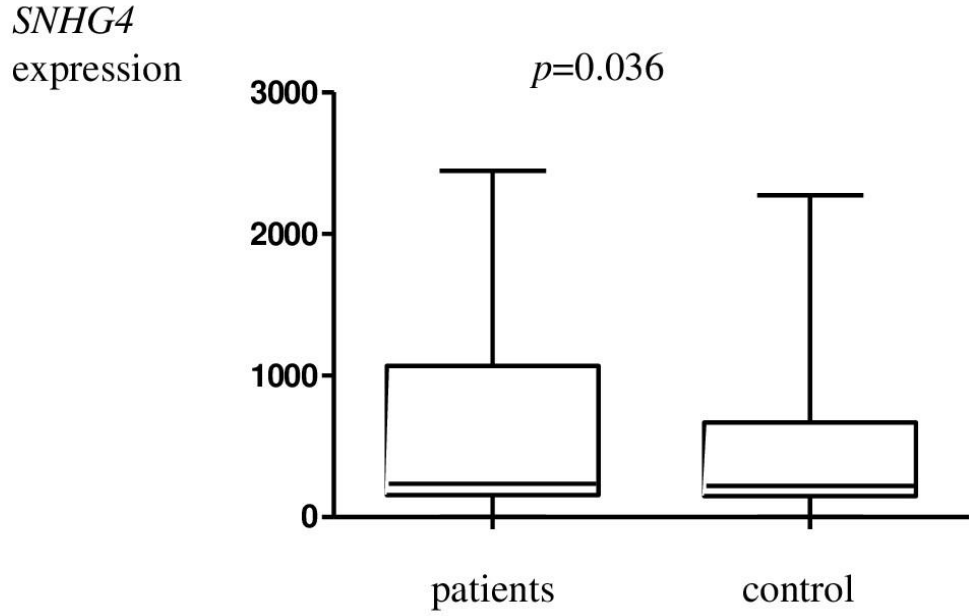
Figure 1. Relative expression of the SNHG4 gene in the test group with respect to the control mate- rial. Table 2. Expression of SNHG4 in endometriosis patients and control.